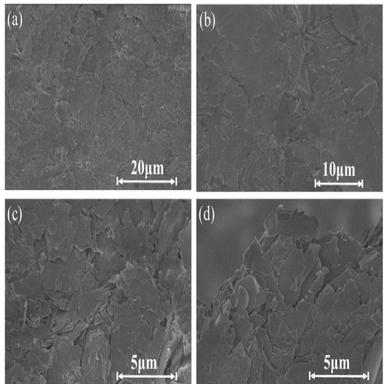
SEM Images of the BNS1 with the scale bars of (a) 20 μ m, (b) 10 μ m, and (c–d) 5 μ m. The morphology of commercial sample 1 is layer-by-layer.